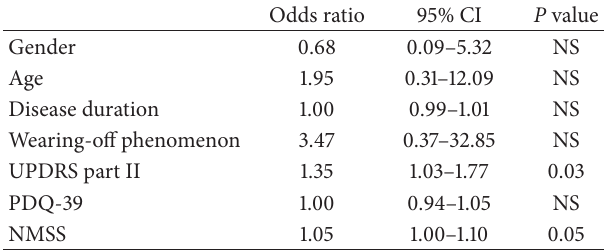
Table 4: Results of multiple logistic regression analysis of GERD in Parkinson’s